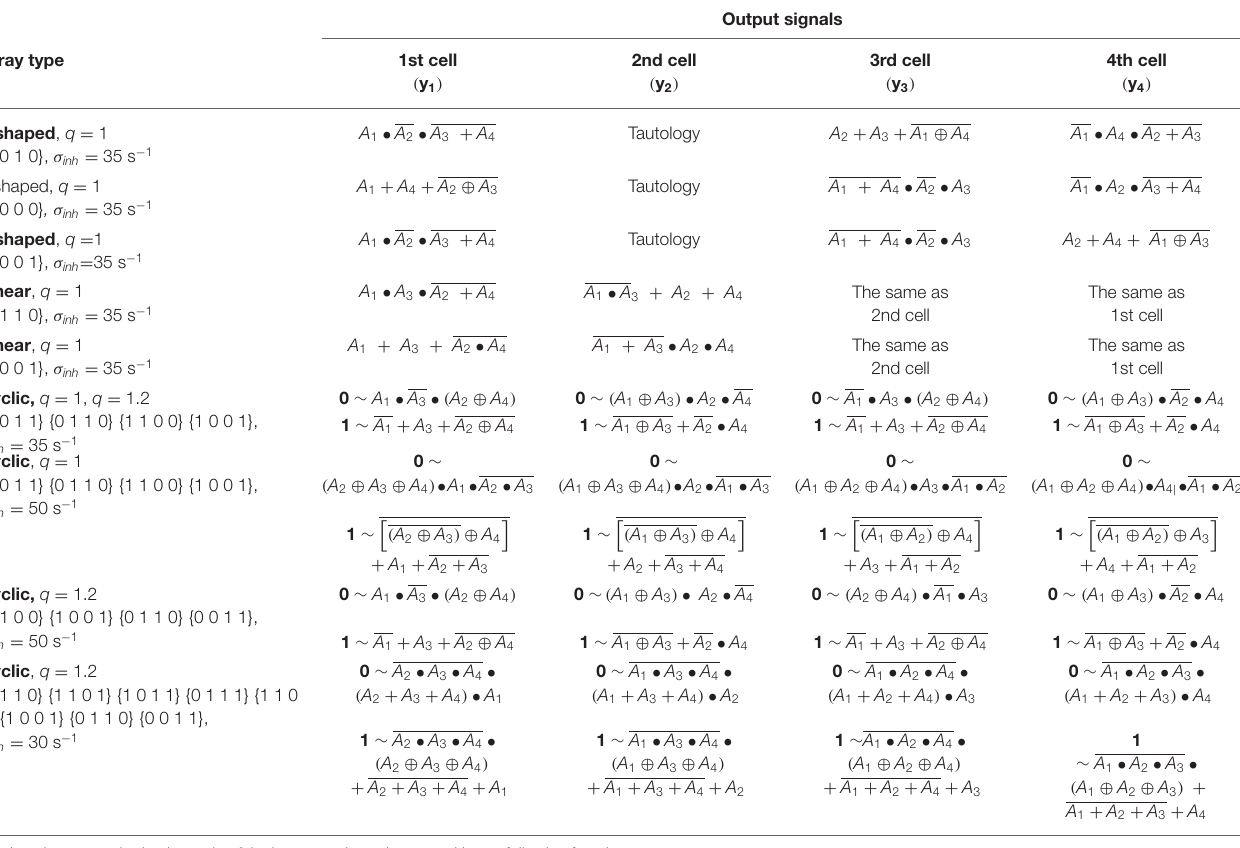
TABLE 4 | Table of output functions in each cell.